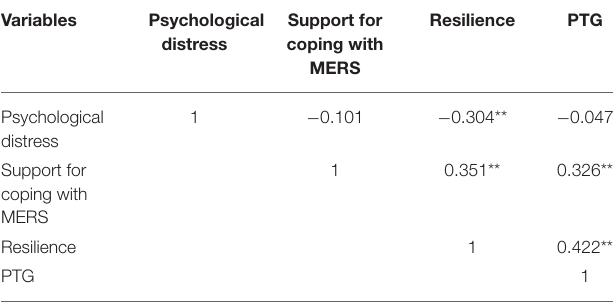
TABLE 4 | Correlations among psychological distress, resilience, support for coping with MERS and PTG ( N = 78).